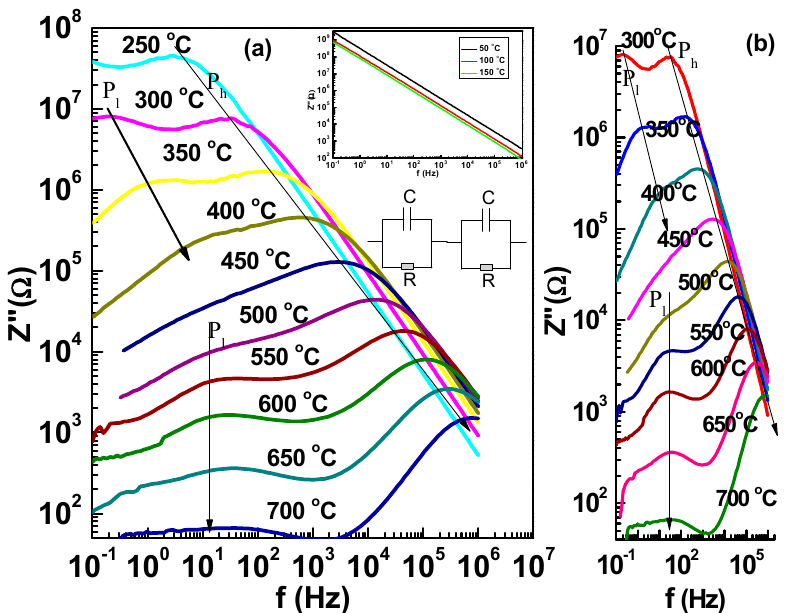
Figure 6. The frequency (f) dependence of the impedance imaginary part ( Z ″ ) for Fe-substituted PMN-32PT ferroelectric crystal at different temperatures ( a ), and the larger version ( b ). The insets show respectively the Z ″ (f) curves and equivalent circuit.